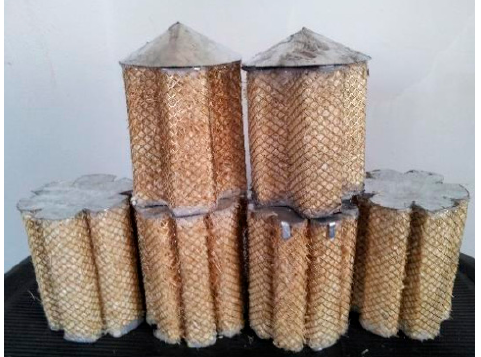
Figure 2. The gear-shaped wood fiber filter. Reprinted from Reference [14], with the permission from the authors.